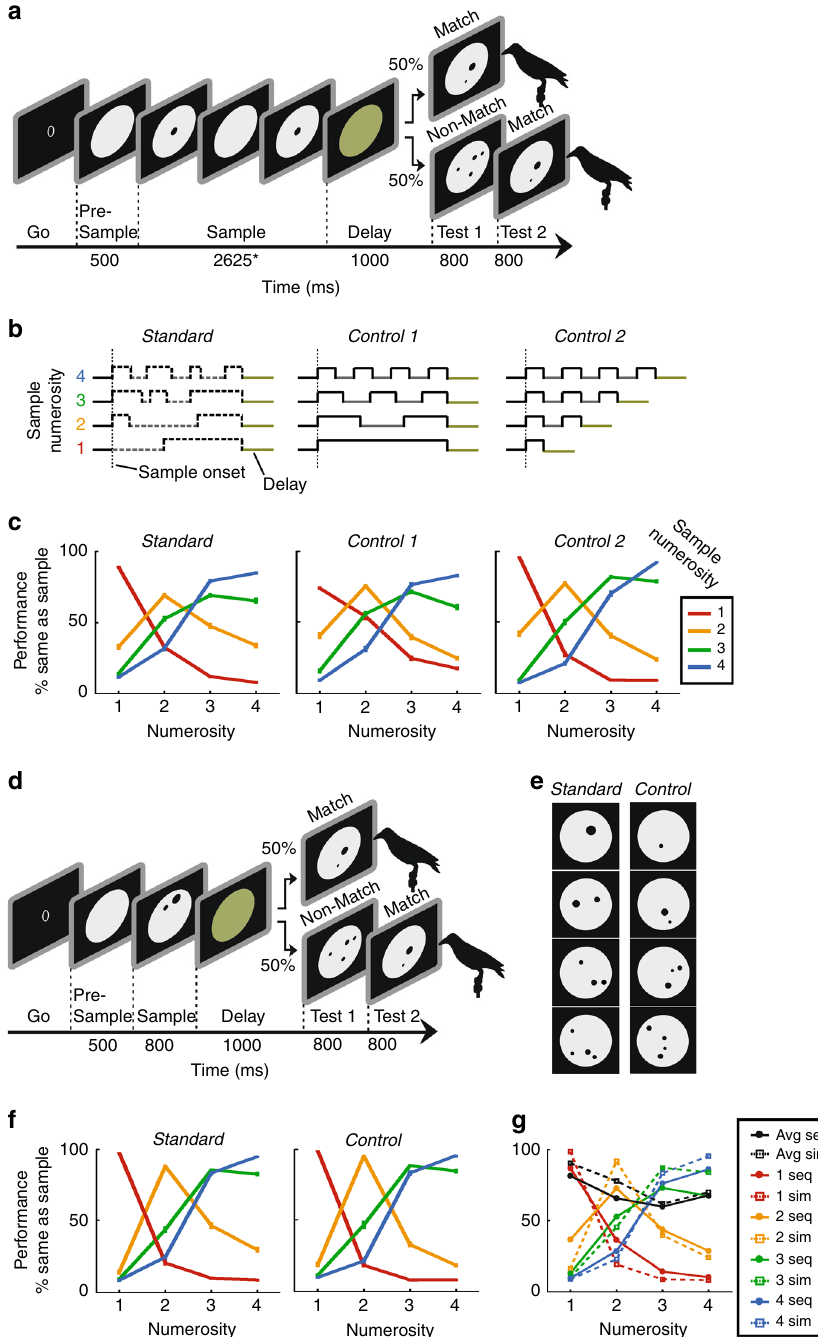
Fig. 1 Task and behavioral performance. a Sequential delayed match-to-numerosity task. A trial starts when the crow enters the light barrier. In this presentation format, the sample numerosity is presented one item at a time, interleaved by pauses. Match and Non-match trials occur with equal probability. The crow has to respond by leaving the light barrier, when sample and test numerosity are equal. b Temporal structure of standard and control trials in the sequential format followed by a 1-s delay. In standard trials, item and pause duration are randomly generated anew for each trial, illustrated by the dashed lines. As constraint, the entire sample duration must add to 2625 ms and item and pause duration must at least be 300 ms long. In temporal control 1 ( “ equal variance ” ), item and pause durations are kept constant within each numerosity but decrease across numerosity, with the overall sample duration kept constant. In control 2 ( “ equal item duration ” ), items and pauses have the same durations across numerosities, while the duration of the sample period increased with numerosity. c Behavioral performance separately for standard and control trials averaged over both crows (error bars ± SEM). The graphs illustrate the probability of a crow judging the test numerosity ( x -axis) as being equal to the sample (color). d Simultaneous delayed match-to- numerosity task. Similar to a , except that sample dots appear at once for 800 ms. e Example standard and control stimuli for the simultaneous presentation format. The control encompasses equal area and equal density across numerosities. Standard stimuli appear as test displays in the sequential presentaion format as well. f Behavioral performance for standard and control trials averaged over both crows in the simultaneous presentation format; layout as in c . g Performance functions of both crows averaged across standard and control conditions for sequential (solid lines) and simultaneous presentation formats (dotted lines). Average percent correct performance per numerosity is depicted by black lines. All error bars indicate ±